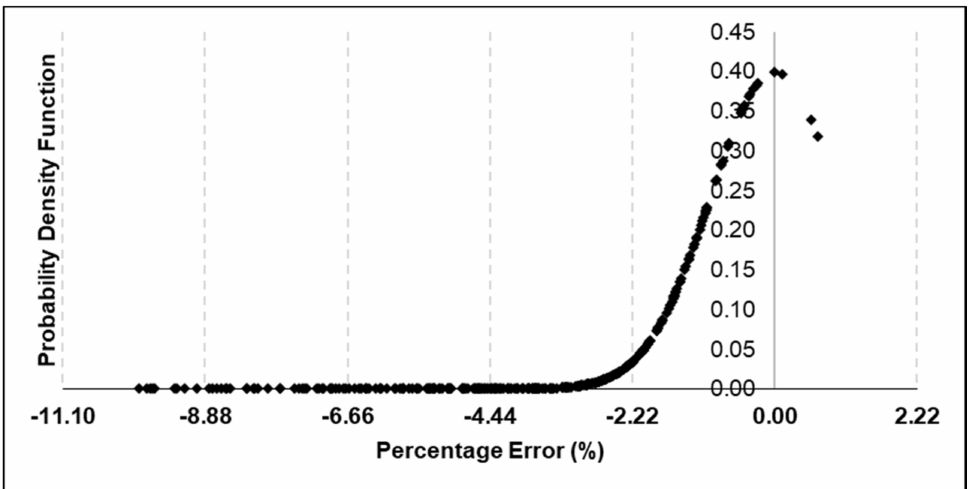
Figure 13. Probability distribution of the percentage error obtained using the newly developed failure pressure prediction method and FEM based on the parameters of the ANN training